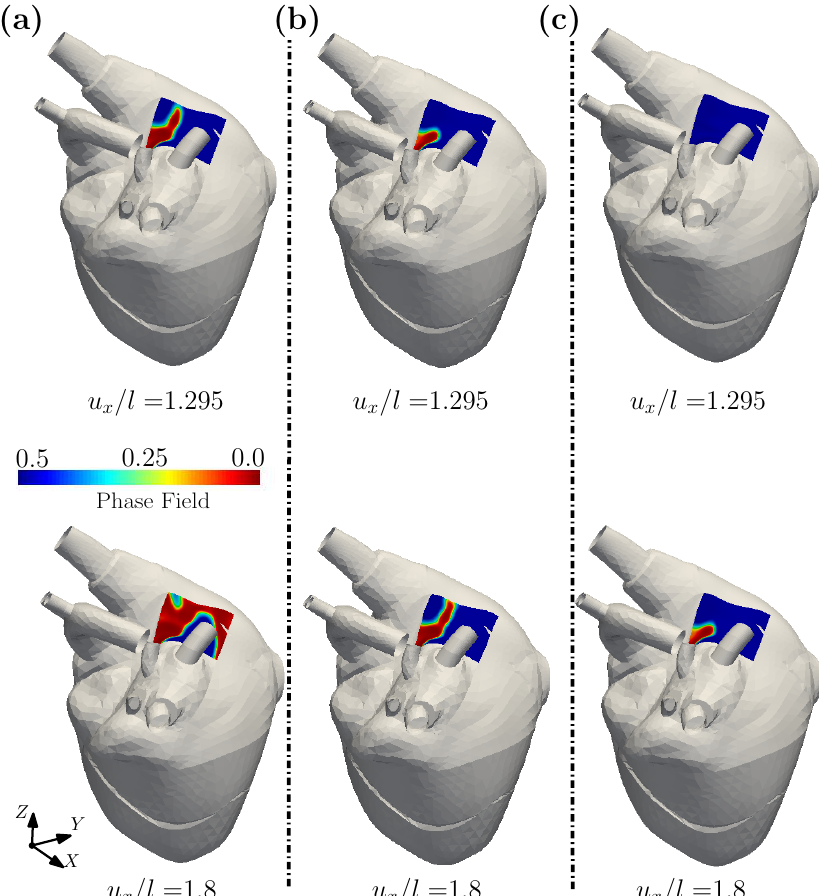
Figure 6. The contour plots of phase field for a biosensor shell with different G c / ( µ (cid:96) ) = ( a ) 0.3 × 10 − 4 ;